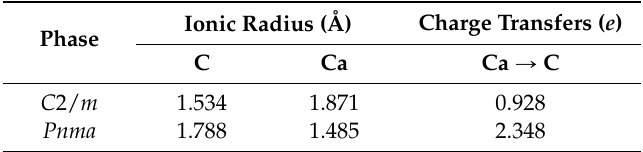
Figure 2. Enthalpy ( a ) and volume ( b ) as a function of pressure. The black and red solid lines represent Pnma -Ca 2 C and C 2/ m -Ca 2 C, respectively. Table 1. Bader charge analysis for C 2/ m - and Pnma -Ca 2 C at 7.8 GPa.